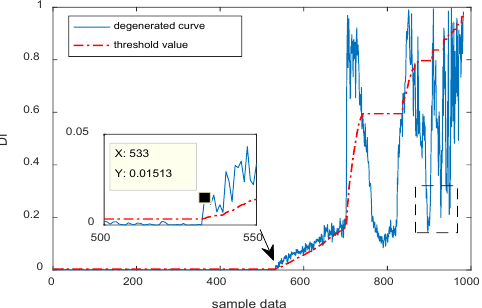
Figure 18. Degradation index based on original features and SVDD.